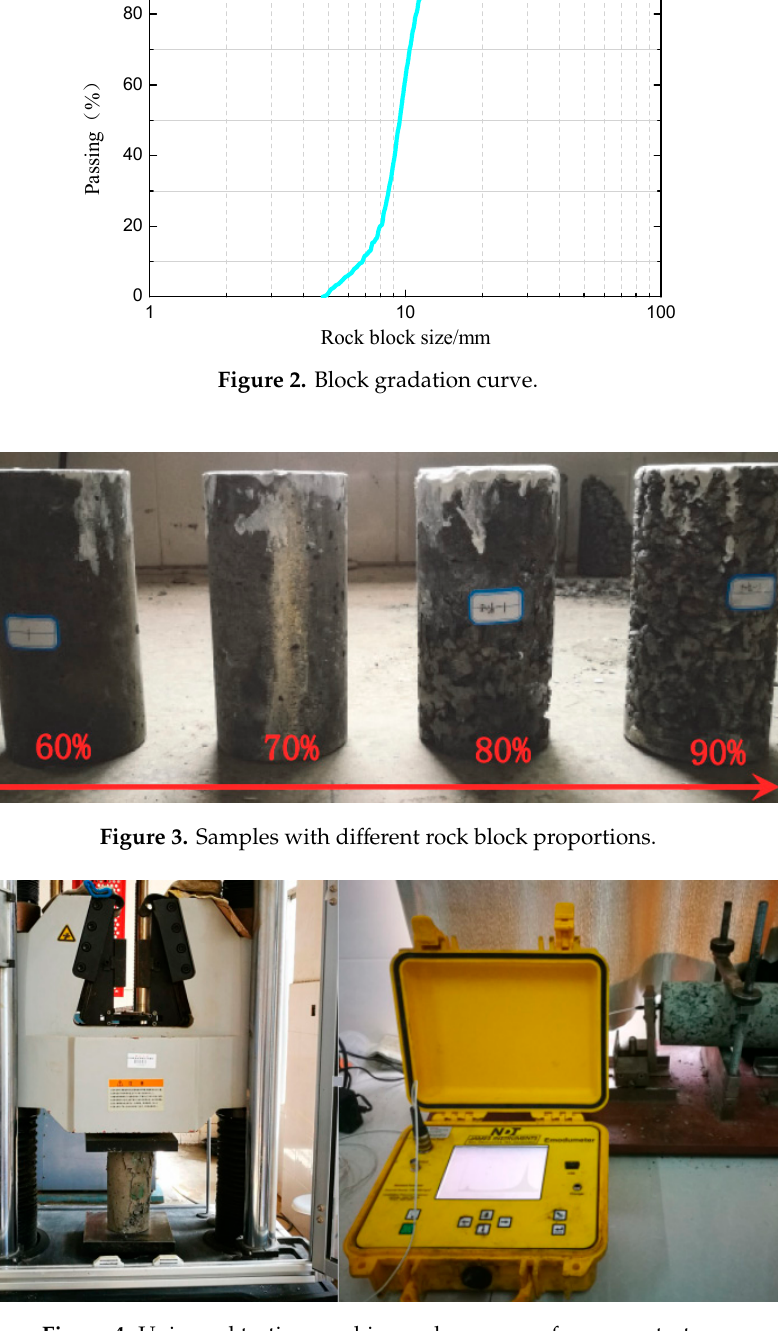
Figure 4. Universal testing machine and resonance frequency tester.